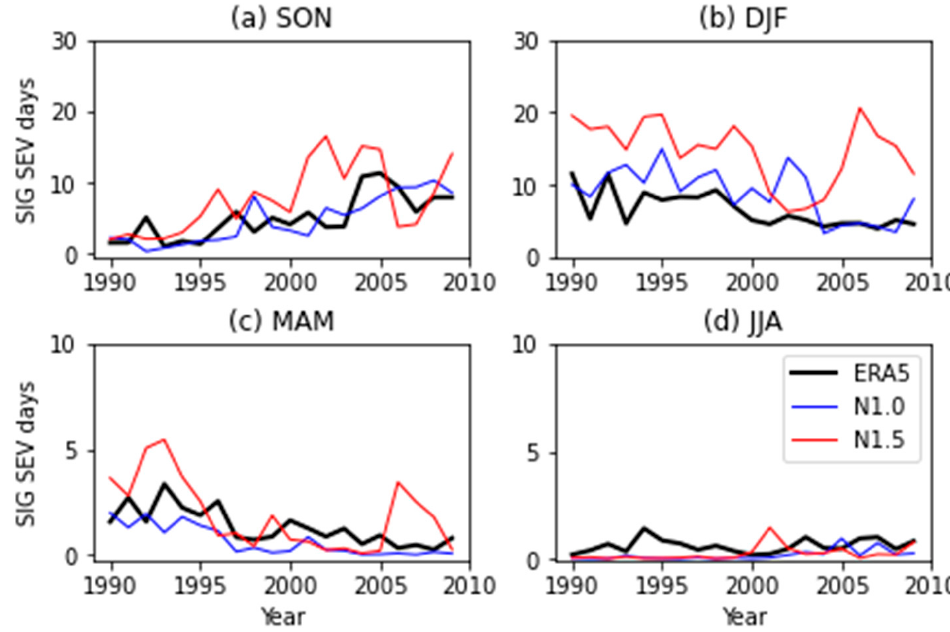
Figure A23. As in Figure A22 except for significant severe thunderstorm potential.